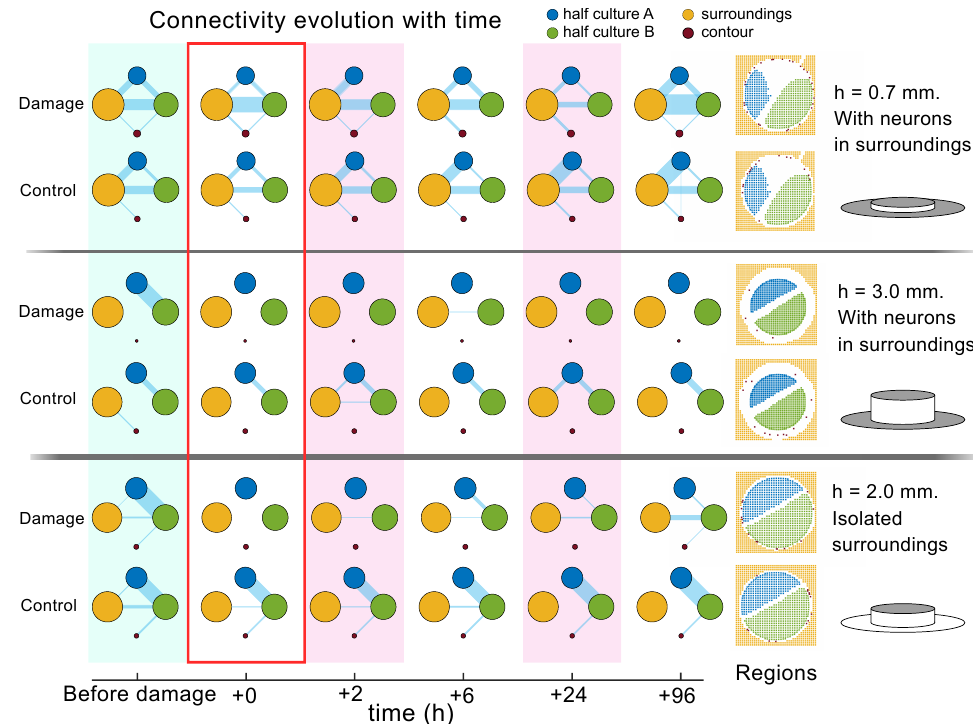
Figure 6. Evolution of functional connectivity upon damage and recovery in homogeneous cultures. The sequence of network diagrams provides three representative damage experiments with varying h and connectivity with the surroundings, together with their corresponding controls. The sketches on the right provide a visual aid to the experimental conditions used. Each group of colored circles that shape a network represents the functional organization between the four regions of the culture (halves ‘A’ and ‘B’, surroundings ‘S’ and contour ‘C’) at different stages of the damage sequence. The condition before damage is marked in green, just after damage is marked with a red contour and recovery at different time intervals is marked with alternating pink and white. The area of the circles is proportional to the number of ROIs it contains. The blue bands capture the interaction between regions, with the thickness of the band proportional to the number of shared functional